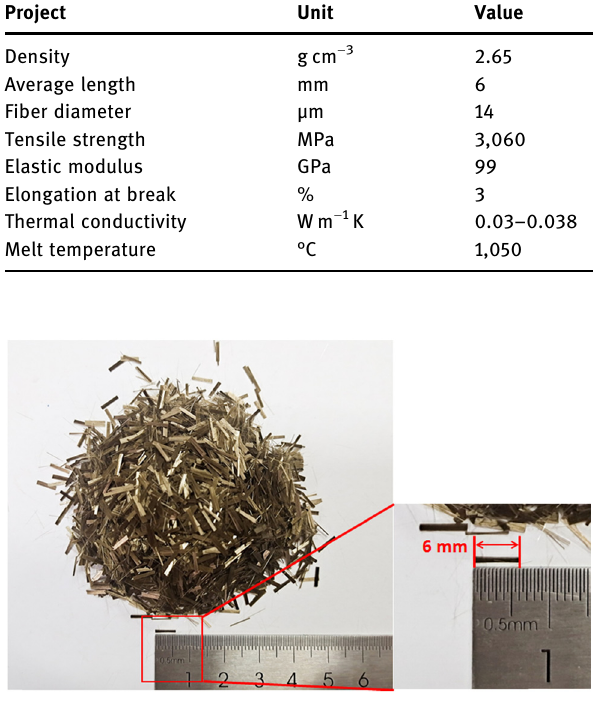
Figure 1: Morphology of 6 mm long basalt fi